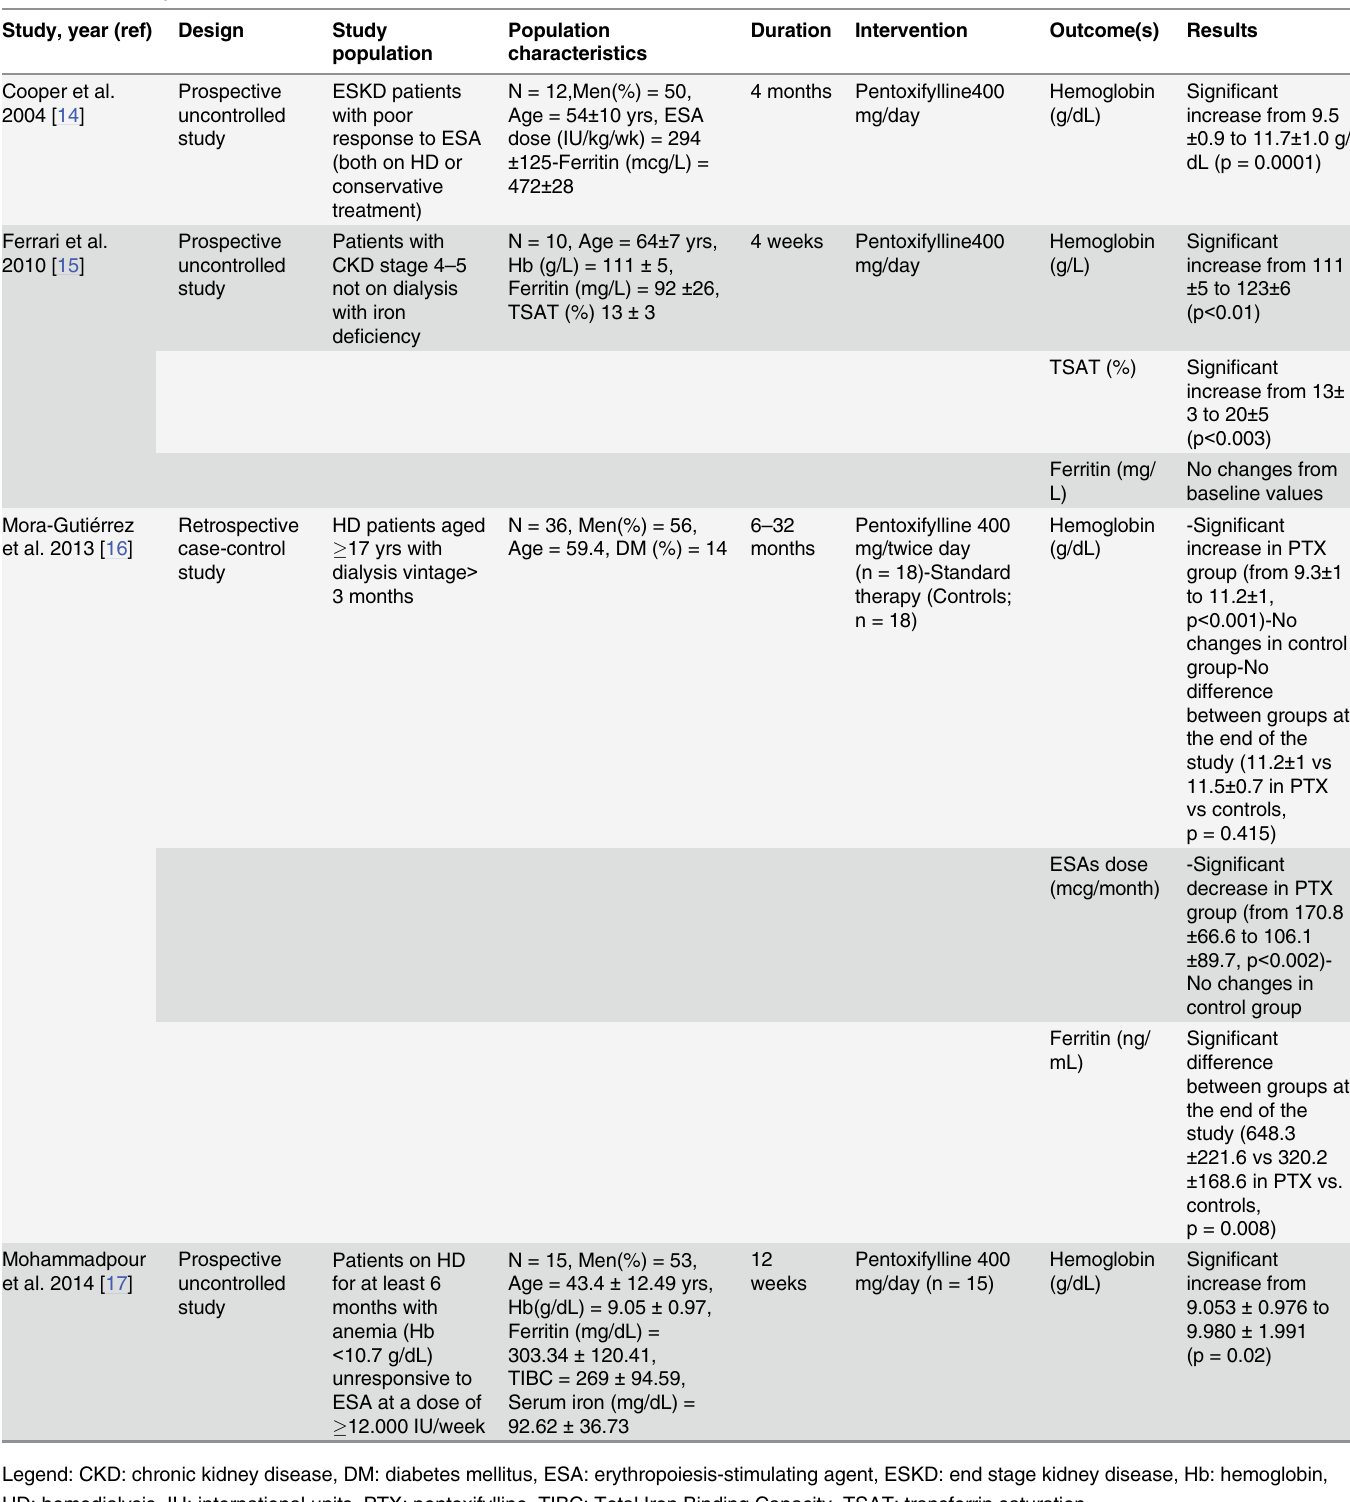
Table 1. Summary of the main characteristics of the non-randomized studies